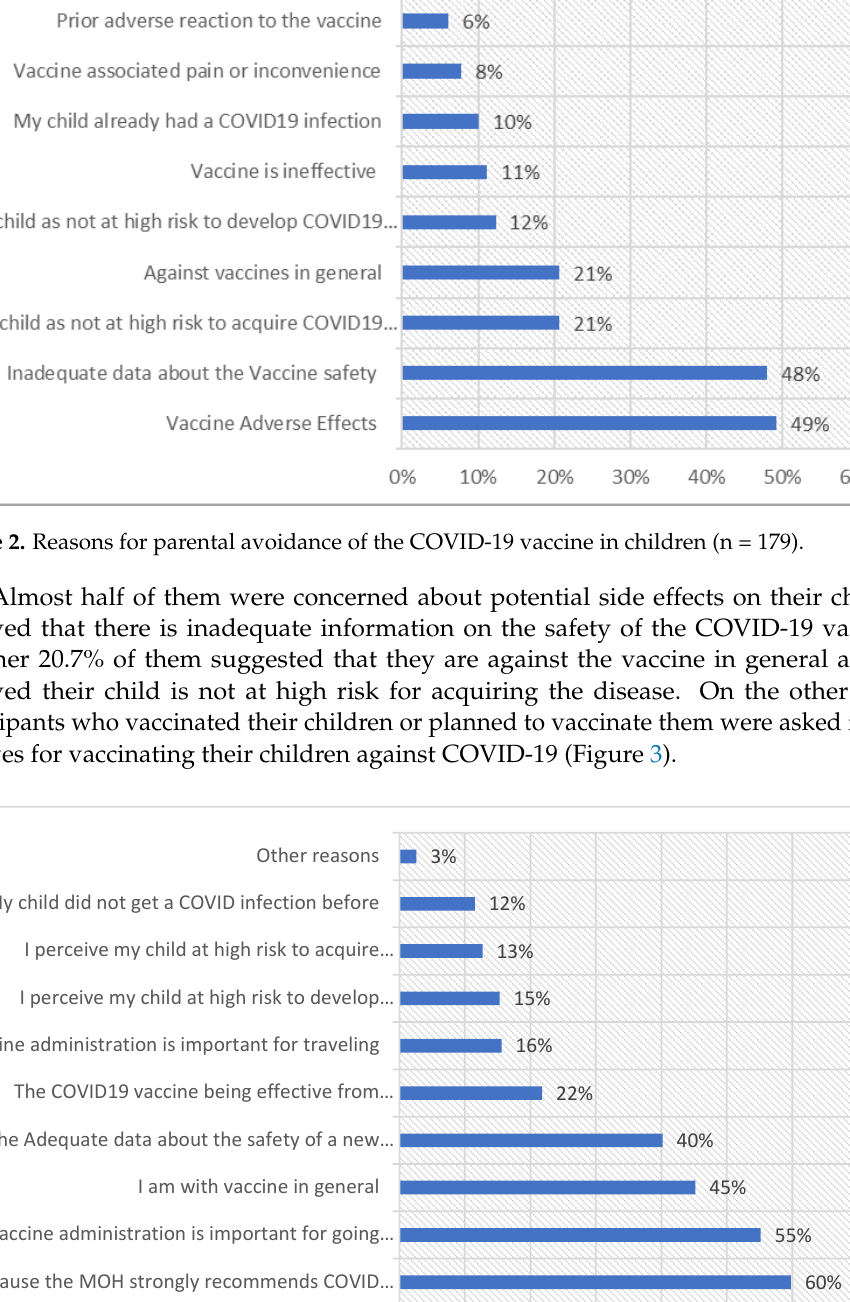
People who stated that their children aged > 12 did not receive COVID-19 vaccines (n = 179) were asked about the reasons for vaccine rejection (Figure 2).